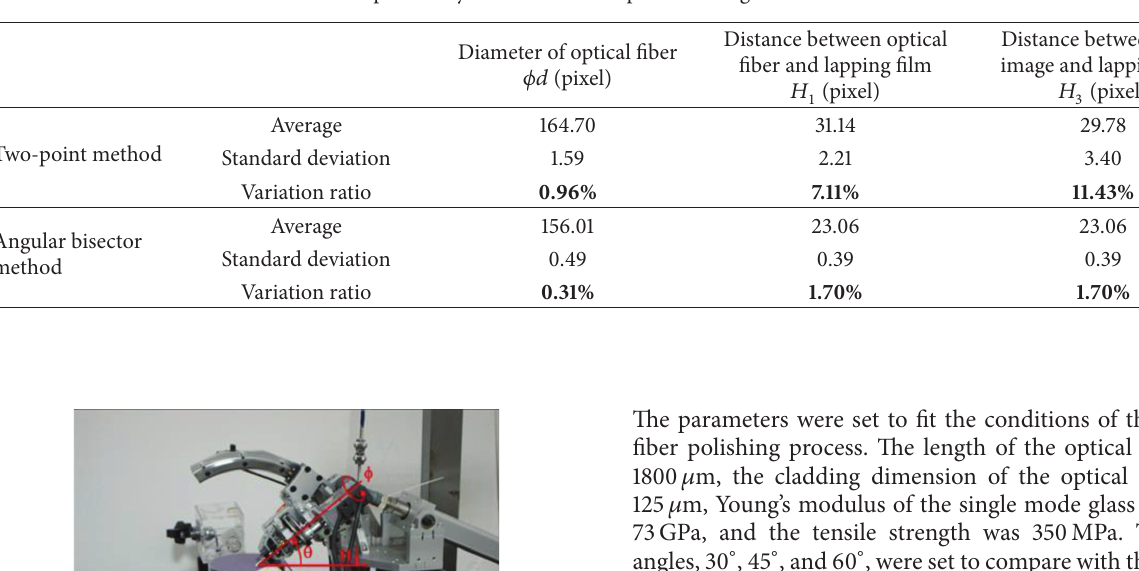
Table 1: Repeatability between the two-point and angular bisector methods.